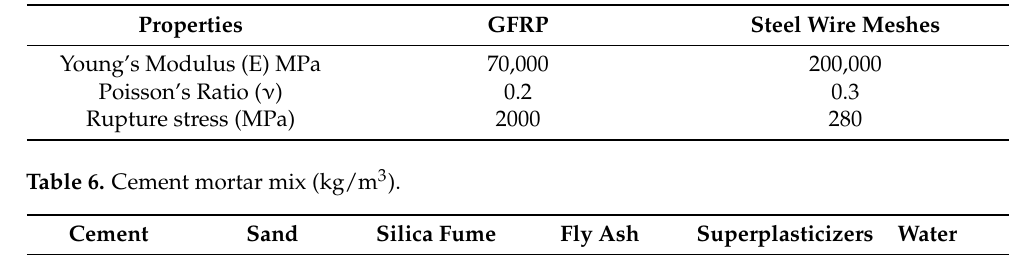
Table 5. Mechanical properties of GFRP and steel wire meshes.